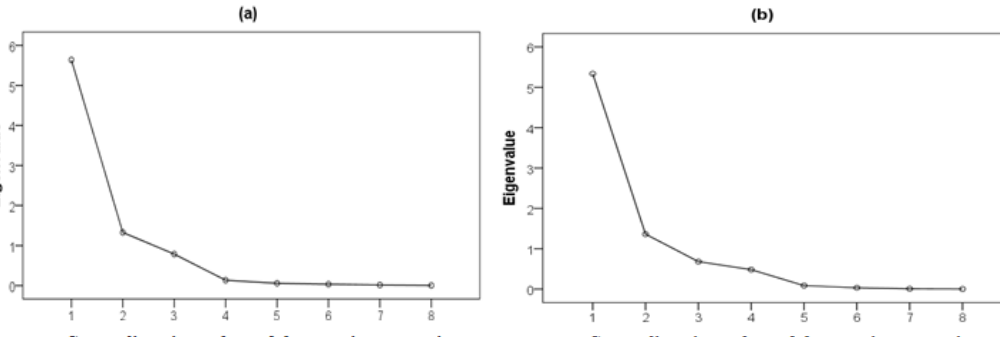
Figure 6. Average eigenvalues for the 30-sample training dataset: ( a ) fish and ( b )